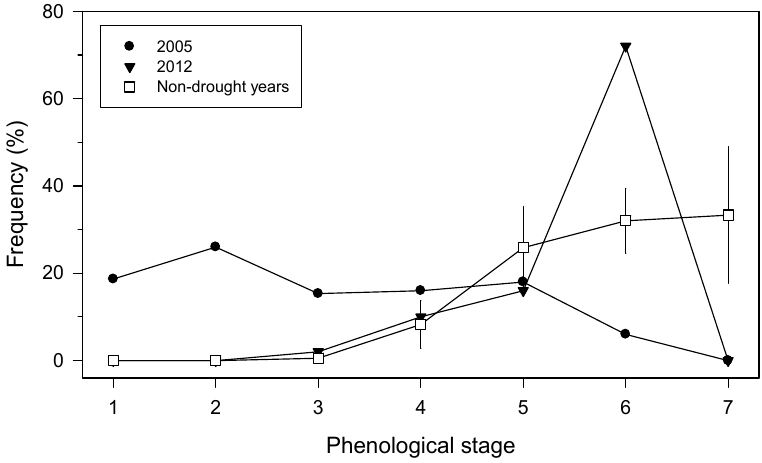
Figure 4. Frequency of holm oak trees ( n = 150) classified in seven spring phenological stages (1 to 7) based on their spring primary growth during the period 2005–2012. The plot shows the two drought years (2005, 2012) and the means (±SE) of non-drought years (excluding 2011 when sampling was done very early, in late April, compared with other years when phenology was recorded in late May). Levels 1 and 7 correspond to the less (swollen buds) and most (finished shoot and male flower formation) advanced stages of primary growth,